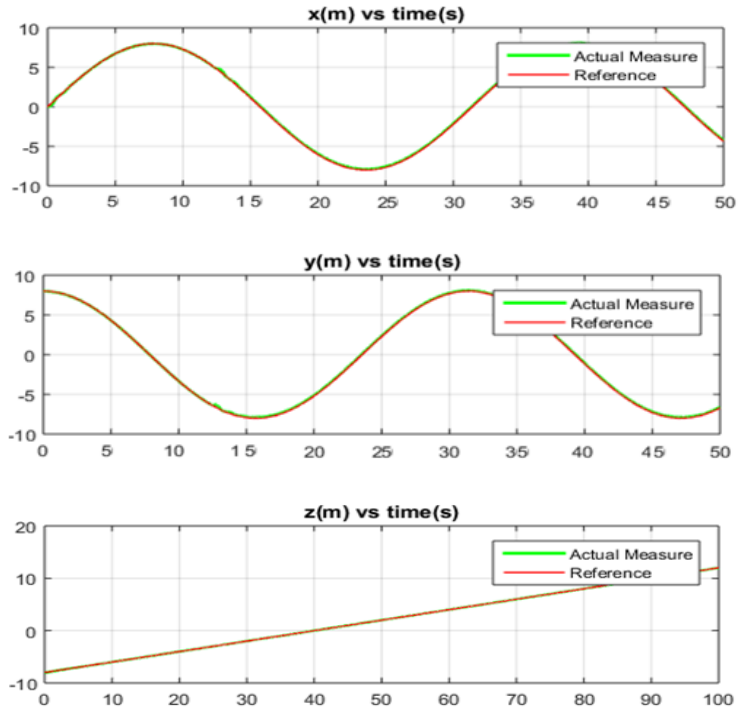
Figure 19. Position response derived using SDF-SMC control technique.